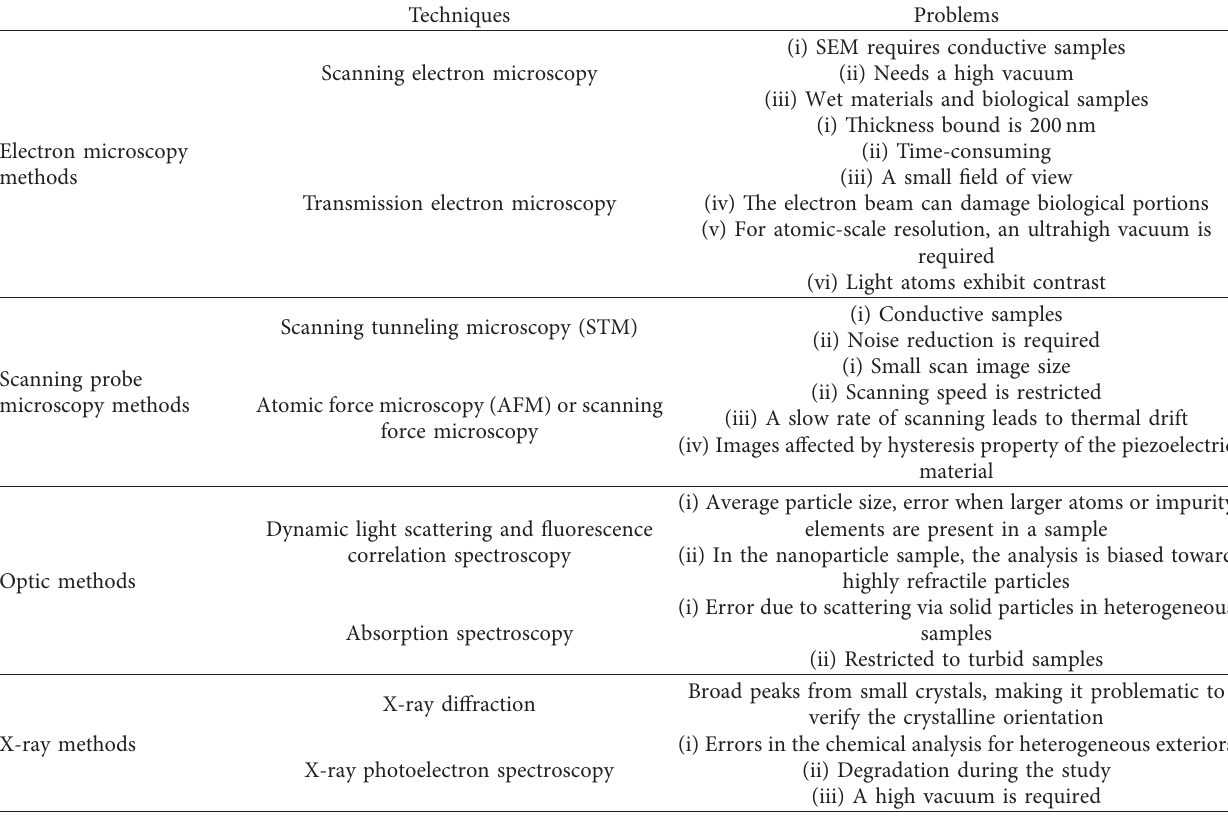
Table 3: Techniques for nanomaterial characterization [71].